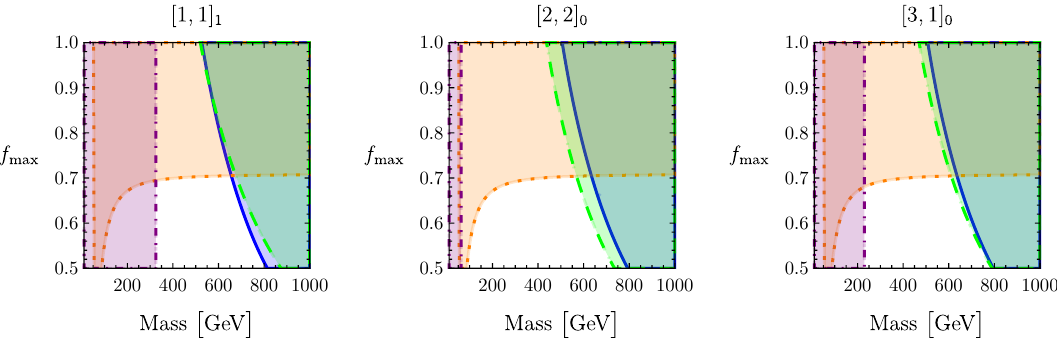
Figure 11 . Expected sensitivity of the HL-LHC to Loryons based on the Higgs coupling projections in [59]. The orange, dotted region is projected to be ruled out by improved constraints on κ κ g ; the green, dashed region can be ruled out by the HL-LHC measurement of the Higgs cubic; the blue, solid region is ruled out by unitarity bounds; and the purple, dot-dashed region is ruled out by current direct search